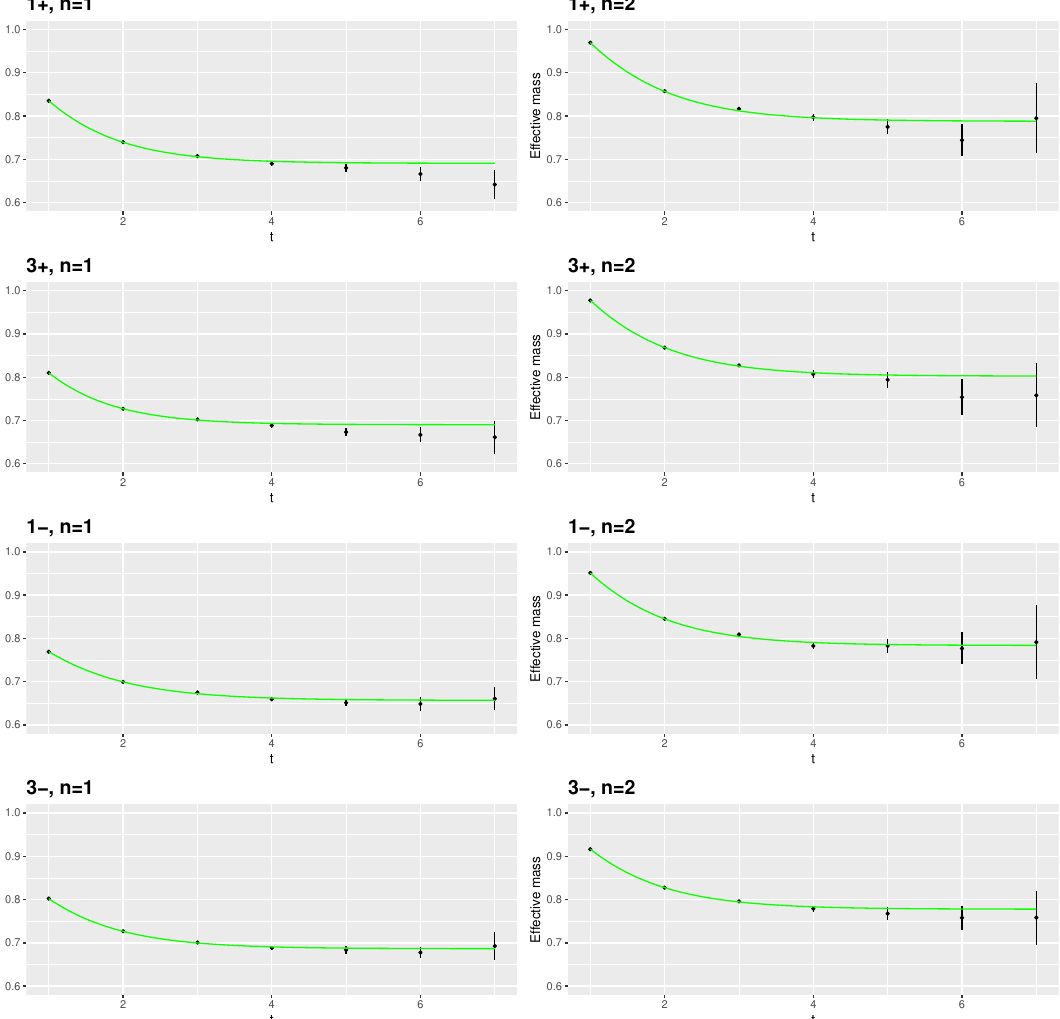
Figure 7. Plot of e(cid:11)ective mass E e(cid:11) ( t ) versus t (with (cid:12)t, green curve) for lowest energy J C =1 (cid:6) ; 3 (cid:6) states.